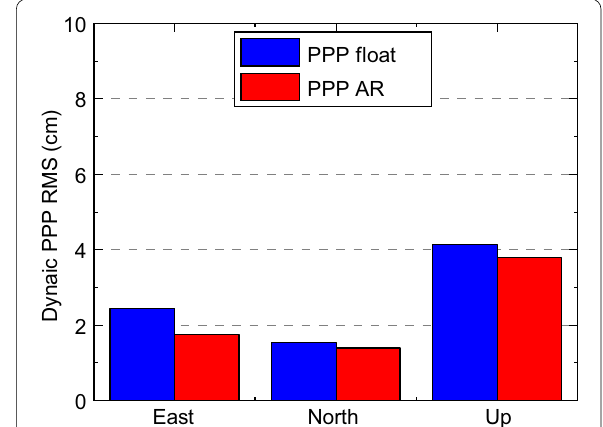
Fig. 14 Average position errors RMS of Kinematic PPP at 24 stations